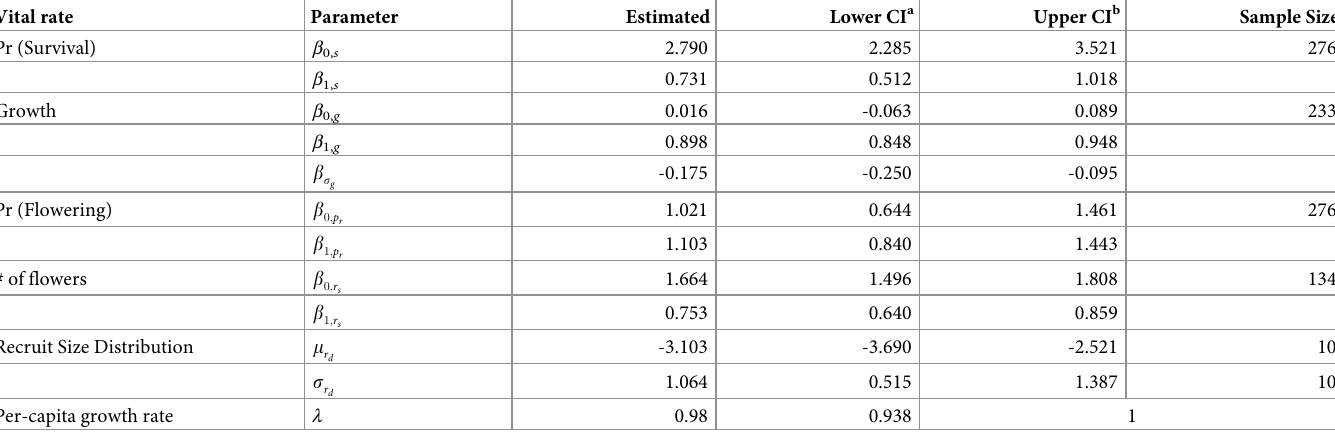
Table 1. Estimated regression coefficients of vital rates and their 95% confidence